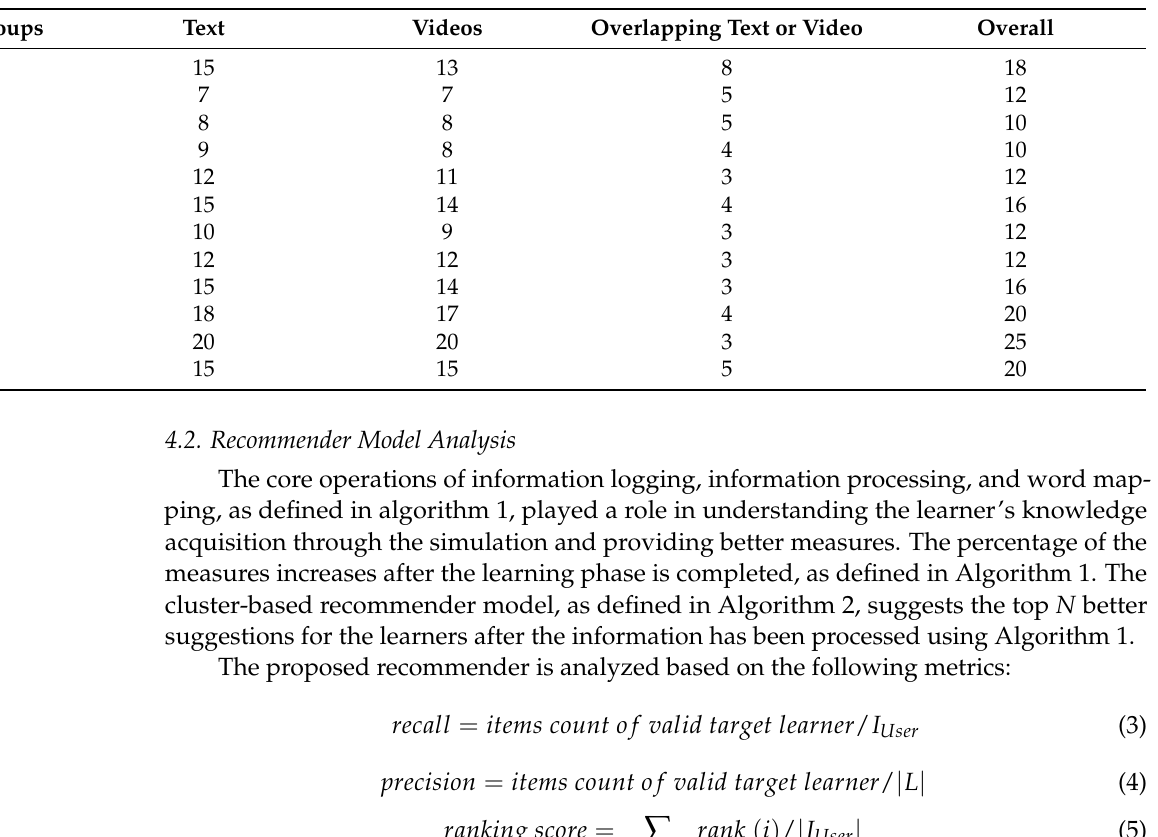
Figure 6. Count of not stemmed words, scored concepts and scored concept groups. Table 3. Percentage of participants addressing the quizzes based on concept groups [7,12–14,17–20]. Table 4. Mean number of words from Q2 retraced to specific text, or video transcripts